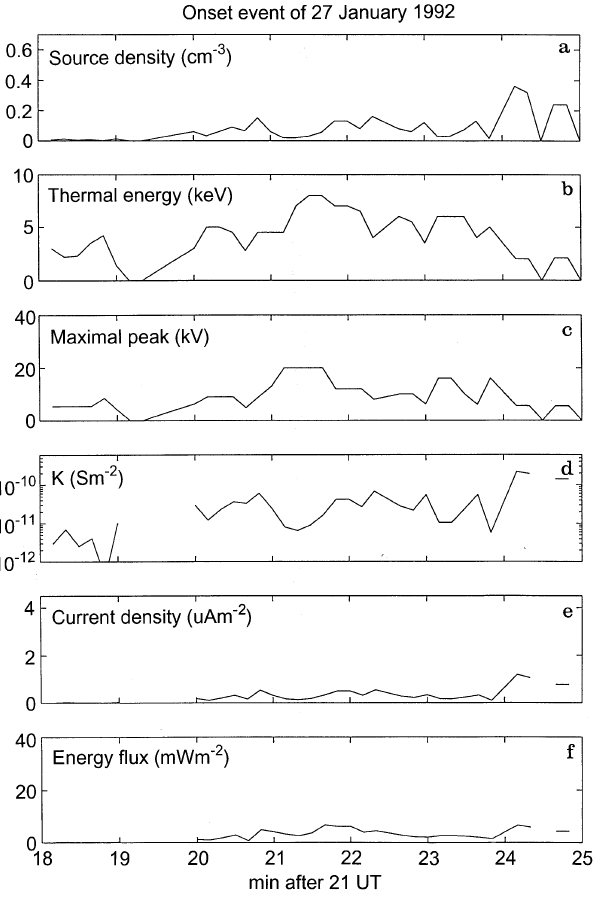
Fig. 5. a Source density, b thermal energy, c field-aligned conduc- tance, d potential drop, e current density and f energy flux esti- mated from each 5-s spectra during the 24 January 1993